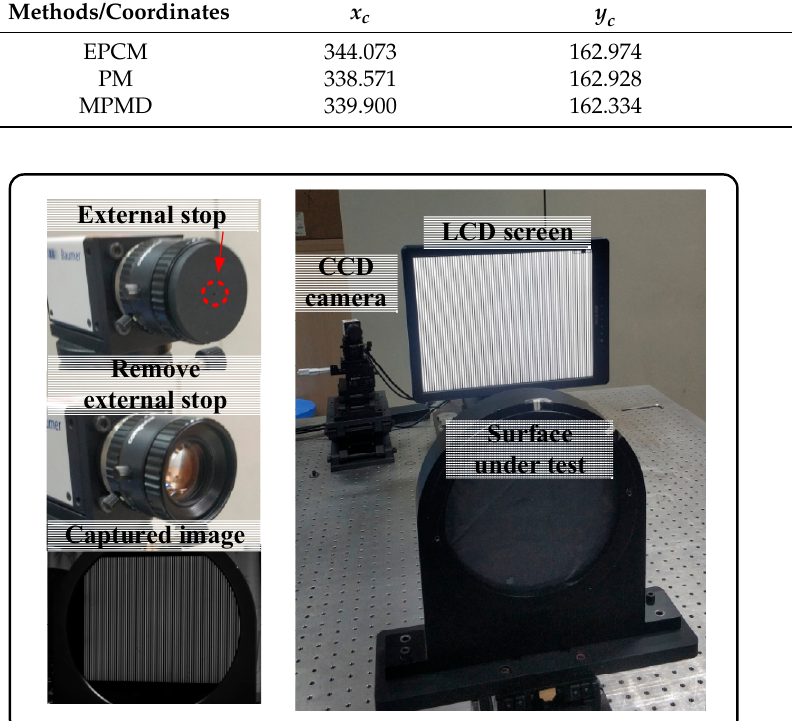
Figure 6. Experimental setup of PMD based on the entrance pupil center.